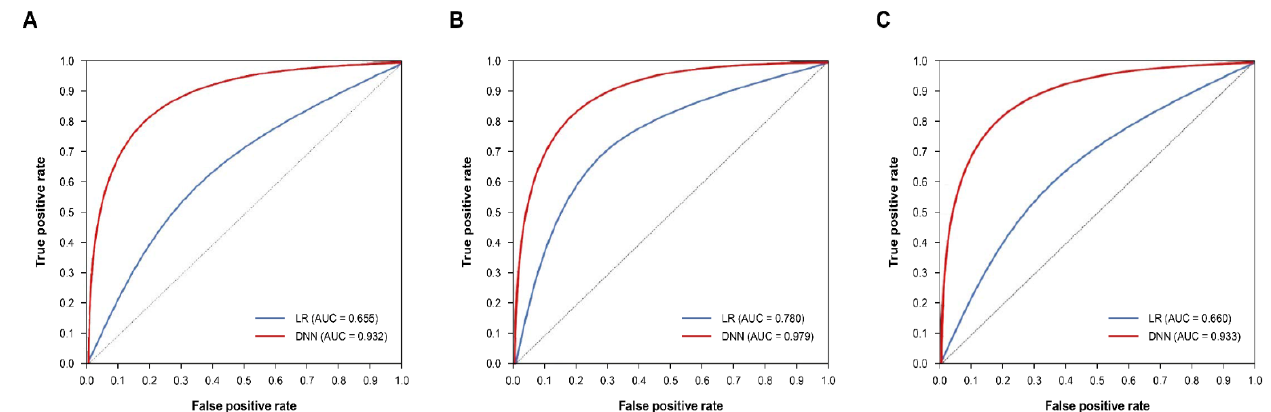
Figure 3. Comparison of ROC curves. ( A ) CVD hospitalization, ( B ) CVD death, ( C ) CVD total (hospitalization + death). ( A ) MI, ( B ) Stroke. AUC: area under the curve. DNN: deep neural network. LR: logistic regression. MI: myocardial infarction. ROC: receiver operating characteristic. p < 0.0001 for all comparisons of ROC curves. Table 3. Performances of logistic regression and deep neural network models for main outcomes.